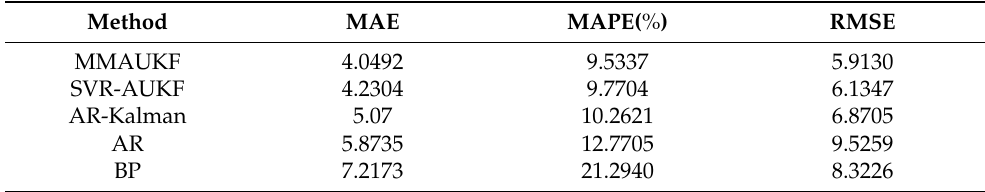
Table 3. The error performance index of MMAUKF and other single model